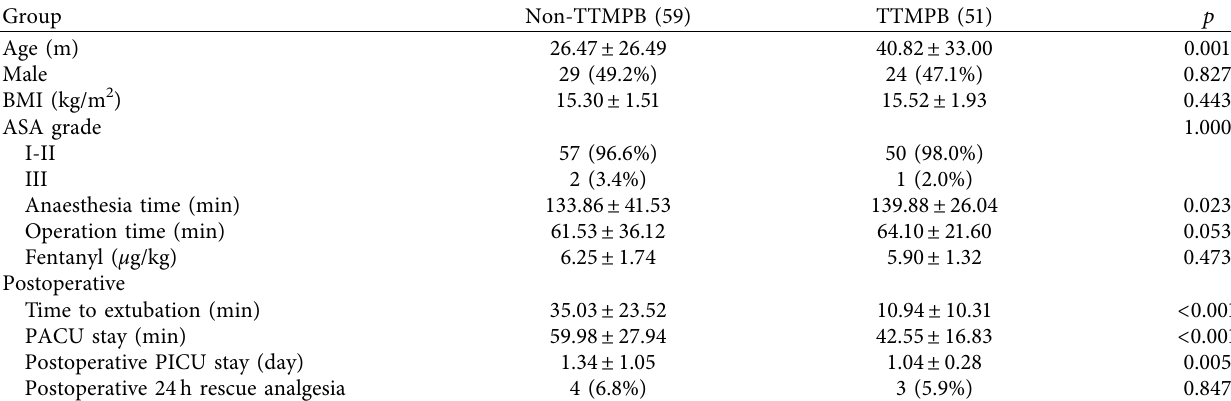
Table 1: Characteristics, procedures, and perioperative data.